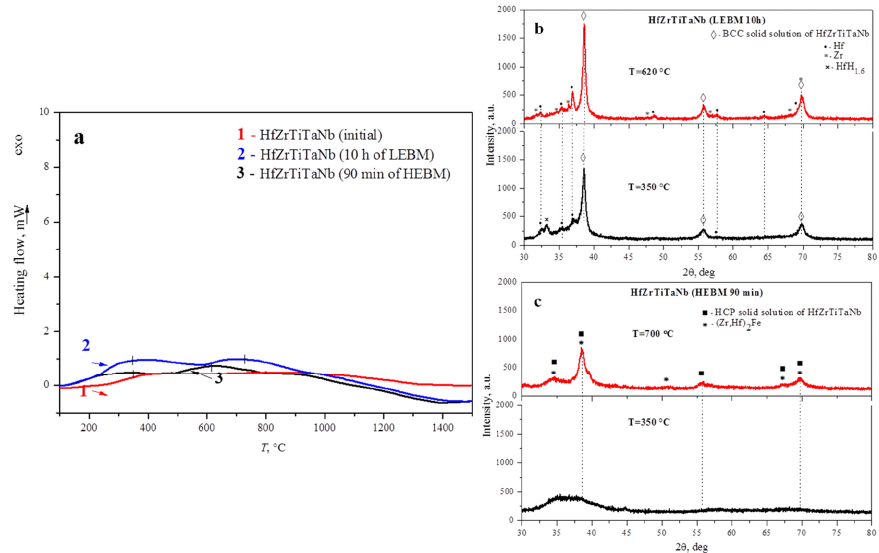
Figure 13. ( a ) DSC curves for HfZrTiTaNb powders: (1) initial, (2) after 90 min of HEBM, and (3) after 10 h of LEBM; ( b ) XRD patterns of LEBM-processed HfTaTiNbZr powder mixtures at 350 °C and 620 °C; and ( c ) XRD patterns of HEBM-processed HfTaTiNbZr powder mixtures at 350 °C and 700 °C.